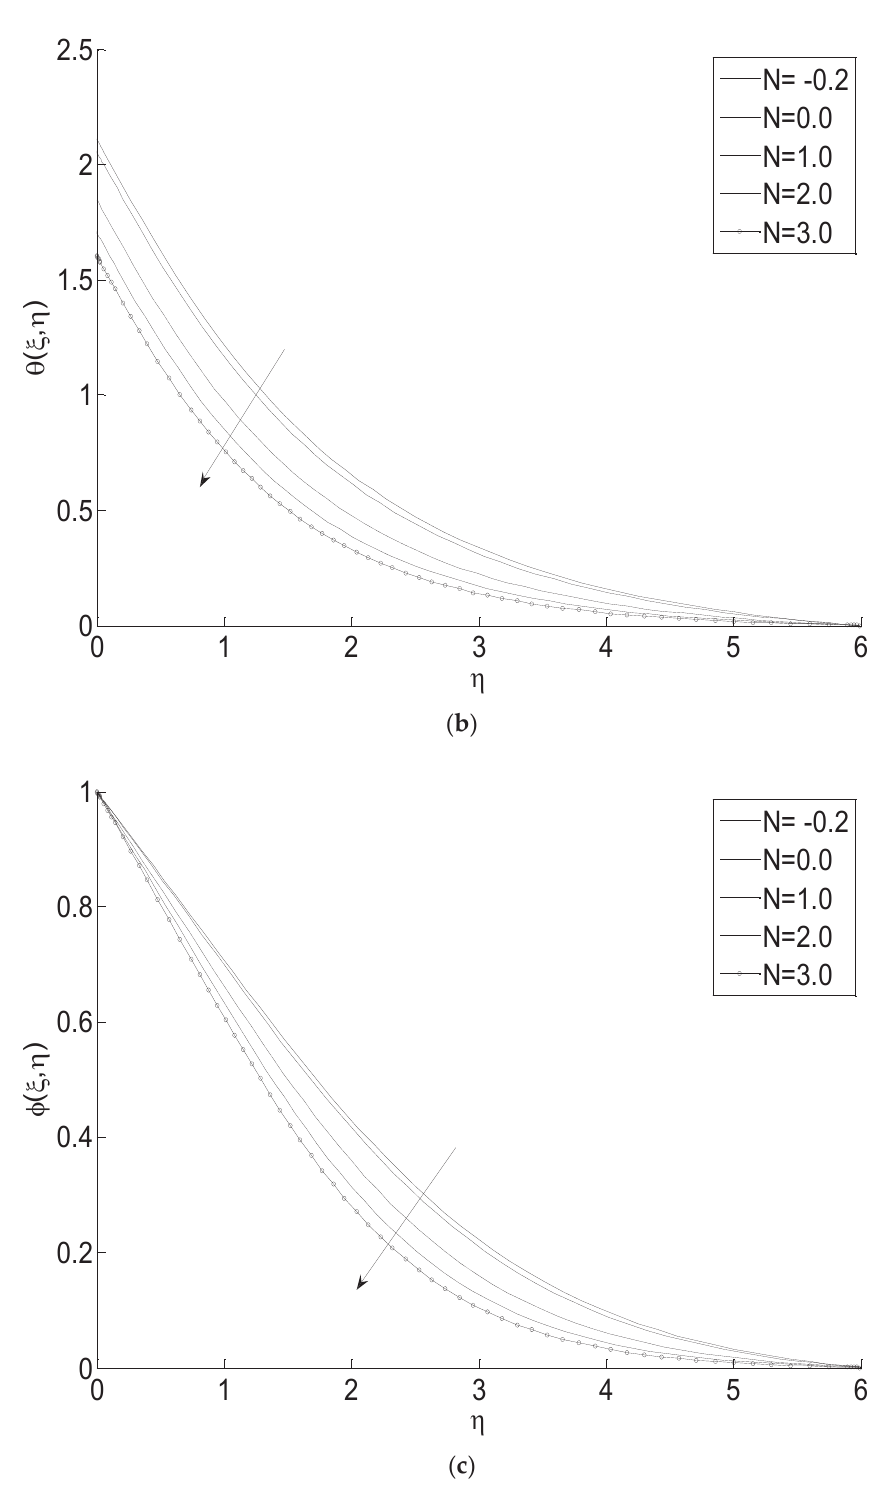
Figure 4. ( a – c ) Velocity, temperature, and concentration profiles, respectively, with different buoyancy ratio at ξ = 1.0, n = 1.0, Sc = 1.0, γ = 2.01, ε = 0.45, f w = 0.0, κ = 0.5, and Nt =